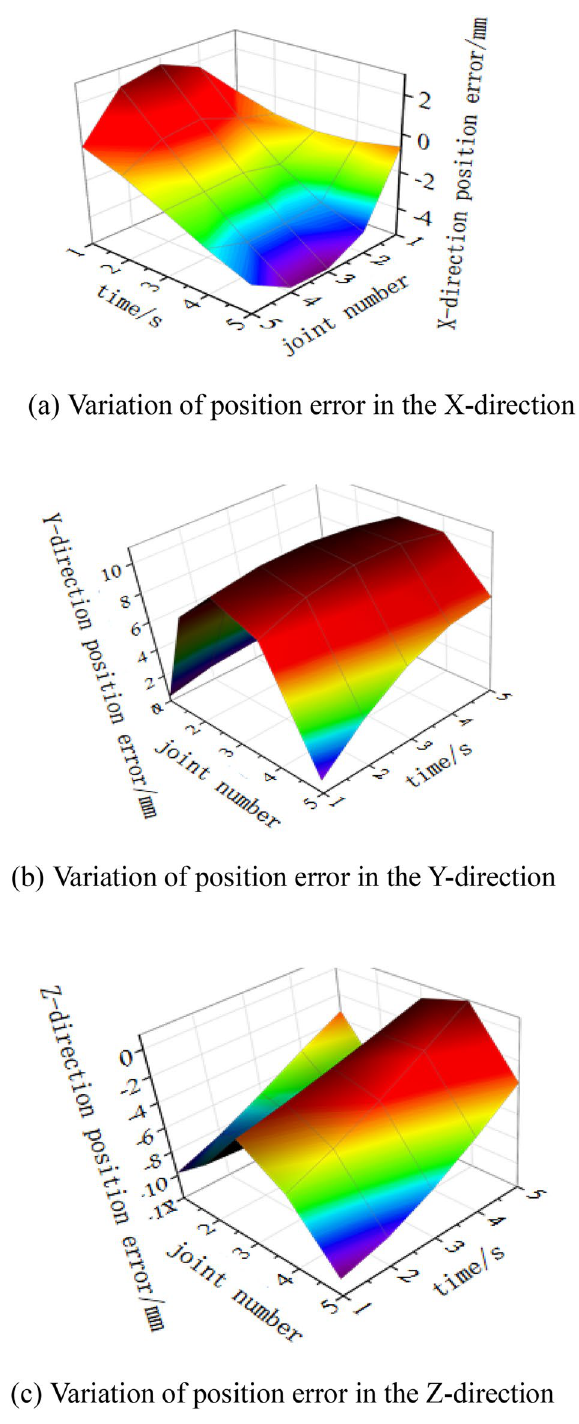
Figure 18. Surface diagram of terminal position error variation. ( a ) Variation of position error in the X-direction, ( b ) Variation of position error in the Y-direction, ( c ) Variation of position error in the